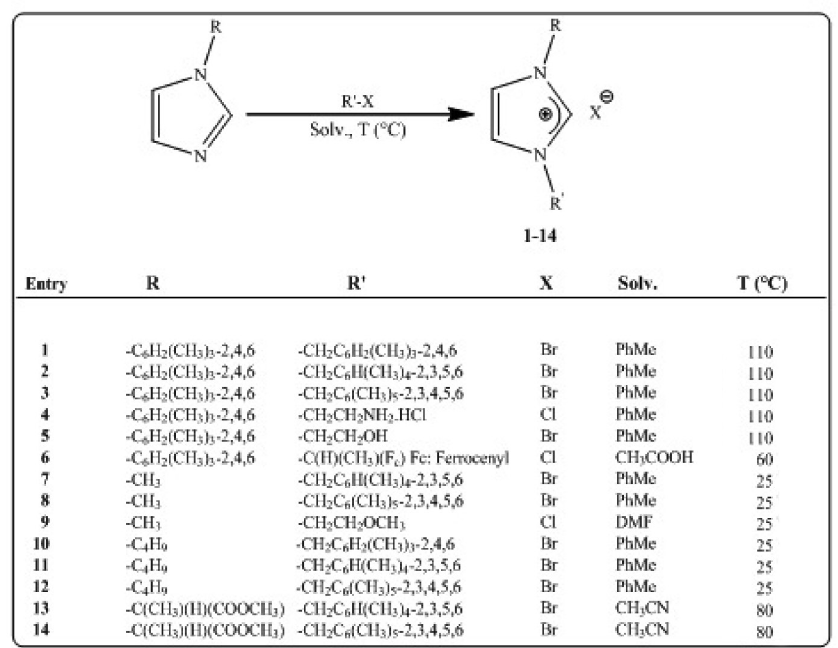
FIGURE 1- Synthesis and formula of the imidazolium salts (1-14) used for antimicrobial